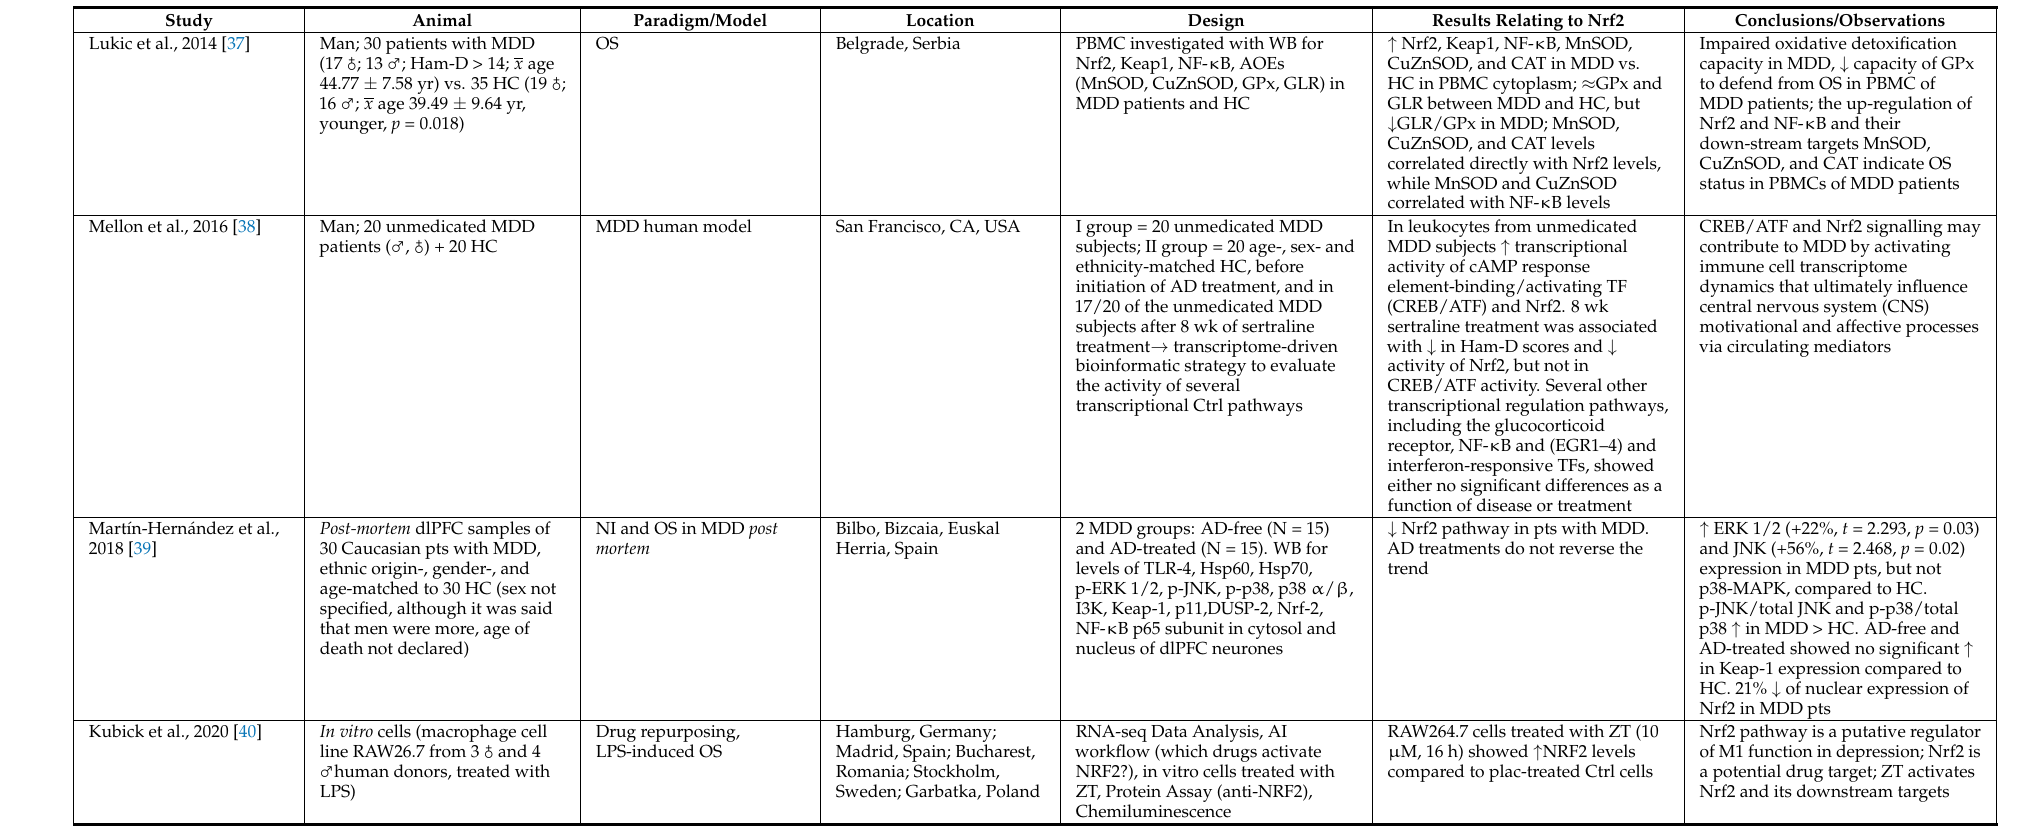
Table 1. Summary of human studies investigating the role of Nrf2 in depression ( in vivo , post mortem , in vitro on cell